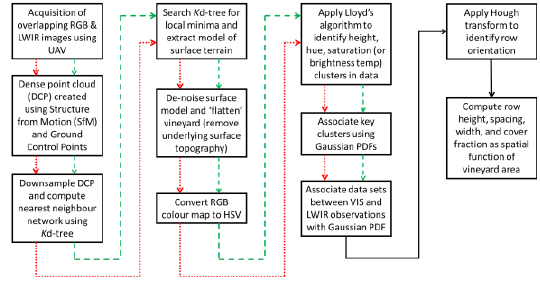
Figure 1: Algorithmic overview of vine macrostructure characterisation algorithm. Red (dotted) and green (dashed) lines indicate processes executed sequentially on both VIS and LWIR imagery. The black (continuous) line indicates processes executed on the joint imagery Image Acquisition: Field experiments took place at the Jacob’s Creek vineyards in the Barossa Valley, South Australia on 8th February 2018 (Figure 2). Visibility was clear, the sky cloudless and air temperatures ranged from temperate (25°C) at about 9.00am to very hot (> 43°C) around 3pm local time. These conditions provide regions of dark shadowing, as well as zones of high irradiance and directionally dependent illumination and reflectance: